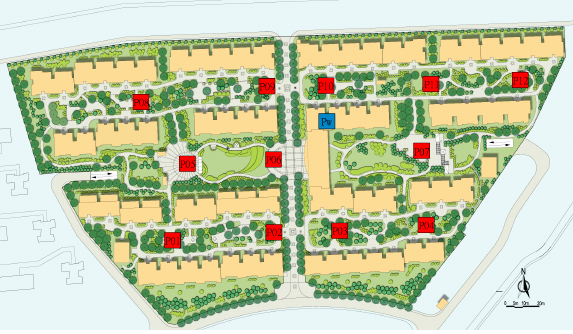
Figure 1. Layout of measurement points in field experiment. 2017 , 8 , 129